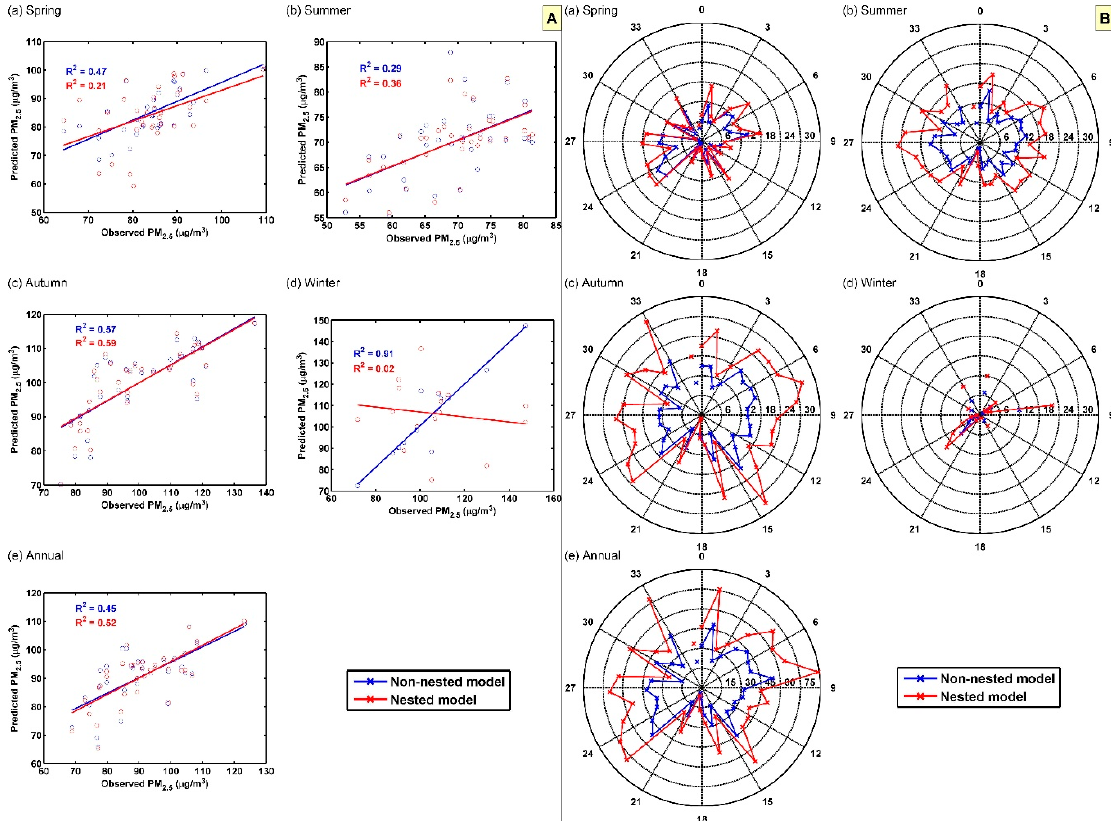
Figure 9. Comparisons between the estimated seasonal and annual PM 2.5 concentrations from the nested and non-nested models. ( A ) regression analysis with the seasonal and annual PM 2.5 observations from the 35 monitoring sites; ( B ) number of available daily PM 2.5 estimates to calculate the seasonal and annual PM 2.5 estimates). ( a – e ) correspond to spring, summer, autumn, winter, and annual in subfigures ( A , B ).